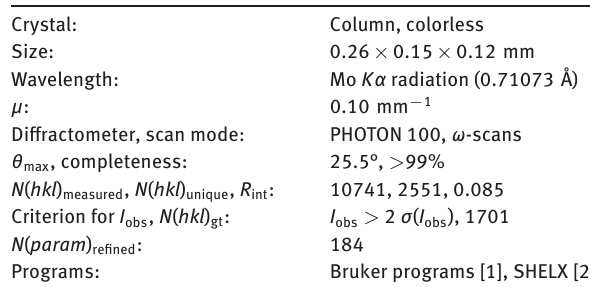
Table 1: Data collection and handling.